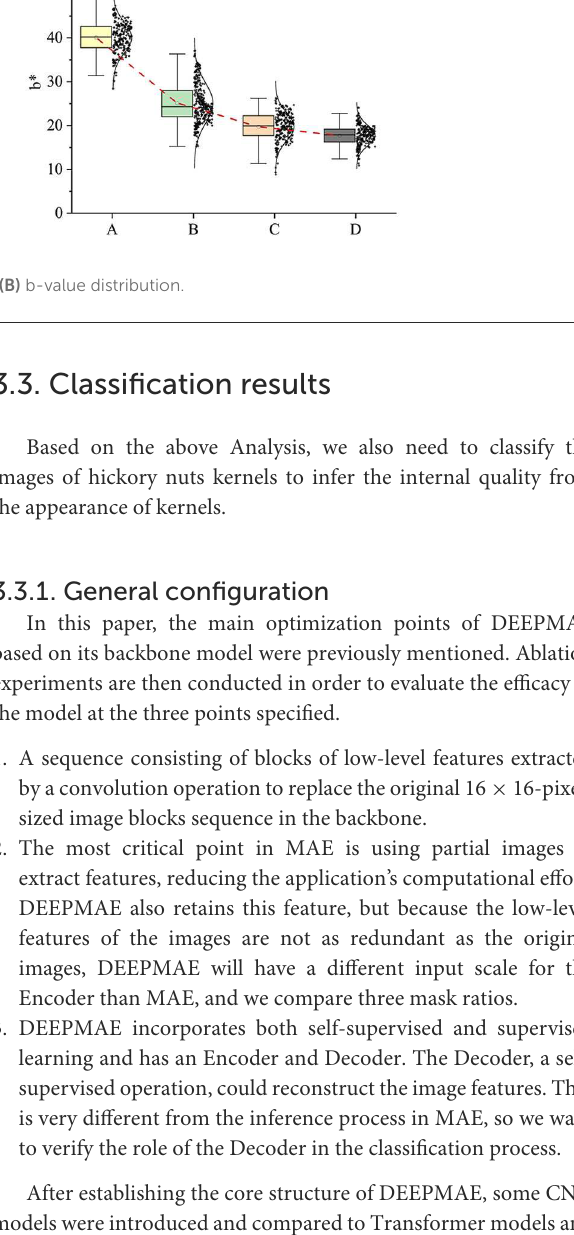
FIGURE5 L-values and b-values distribution of original images. (A) L-value distribution; (B) b-value distribution.